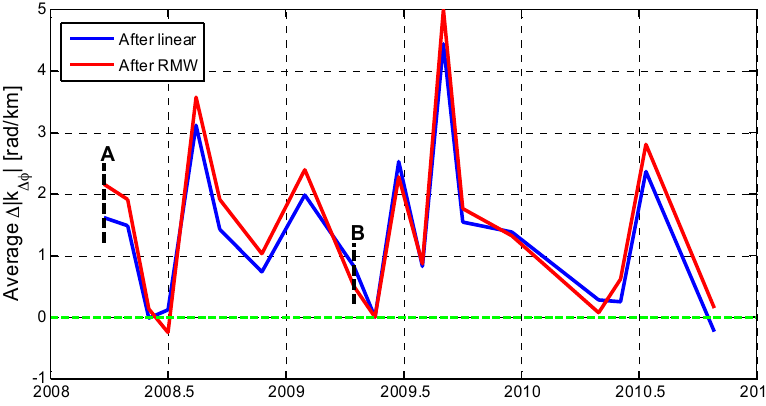
Figure 7. The difference value | | k ∆ indicates a reduction or increase in local correlation with topography before and after tropospheric correction. This graph shows a comparison of the average | | k ∆ in the center of 28 blocks for the corresponding interferogram after the correction for the linear (blue solid line) and RMW methods (red solid line). A comparison of A and B indicated by dashed black lines are specifically shown in Figure 8.